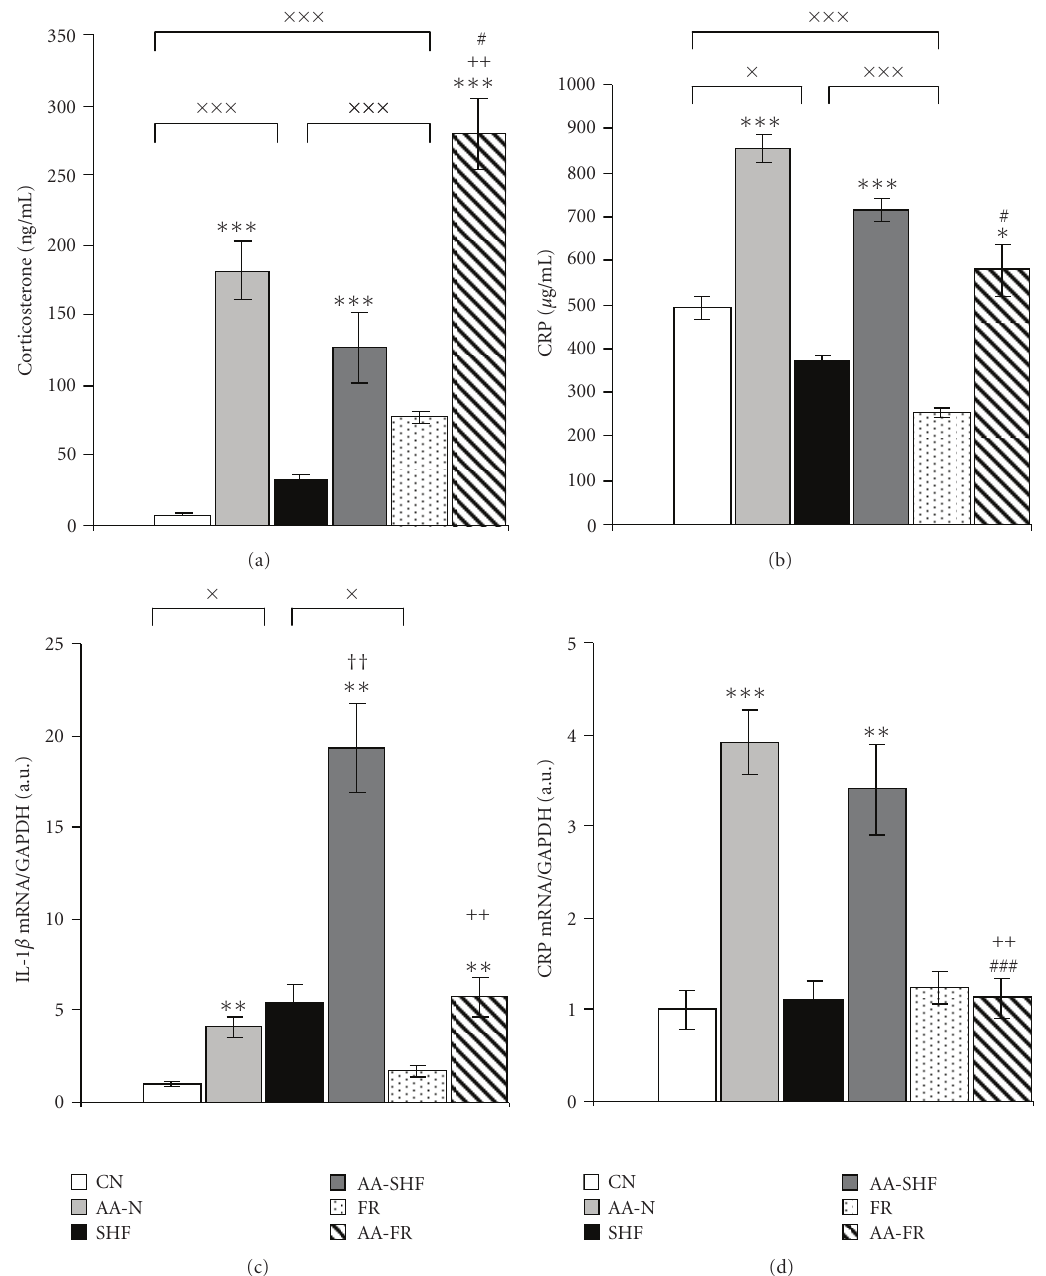
Figure 2: Plasma corticosterone (a), plasma CRP (b), IL-1 β mRNA expression (c), and CRP mRNA expression (d) in the liver of healthy control (CN, SHF, FR) and arthritic rats (AA-N, AA-SHF, AA-FR) measured on day 18 after cFA inoculation. Results of mRNA expressions are expressed in arbitrary units as the ratio of given mRNA to GAPDH. Significant di ff erences between healthy controls on di ff erent dietary regime: × P < . 05, ××× P < . 001. Statistical significances: control rats versus arthritic rats on the same dietary regime ∗ P < . 05, ∗∗ P < . 01, ∗∗∗ P < . 001; AA-FR versus AA-N # P < . 05, ### P < . 001; AA-FR versus AA-SHF ++ P < . 01; AA-SHF versus AA-N †† P < . 01. For abbreviations see Figure